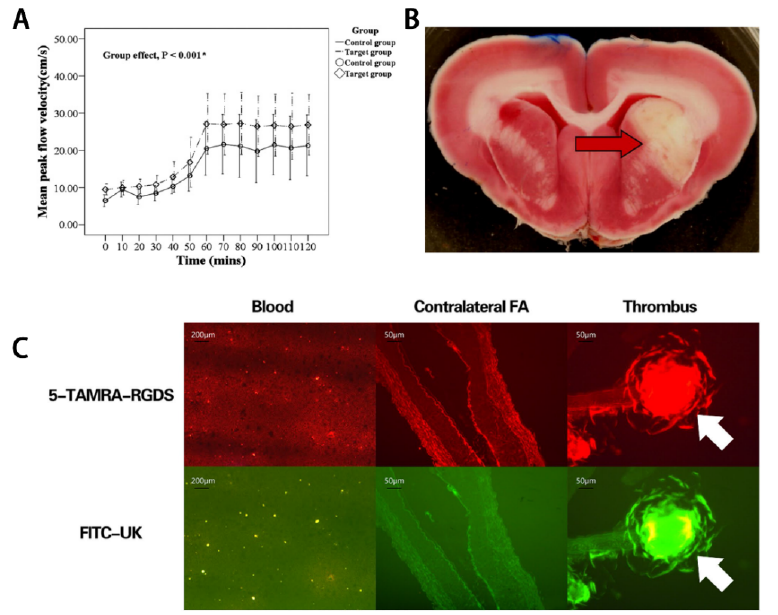
Figure 2. ( A ) Microbubbles combined with urokinase significantly improved blood flow (the